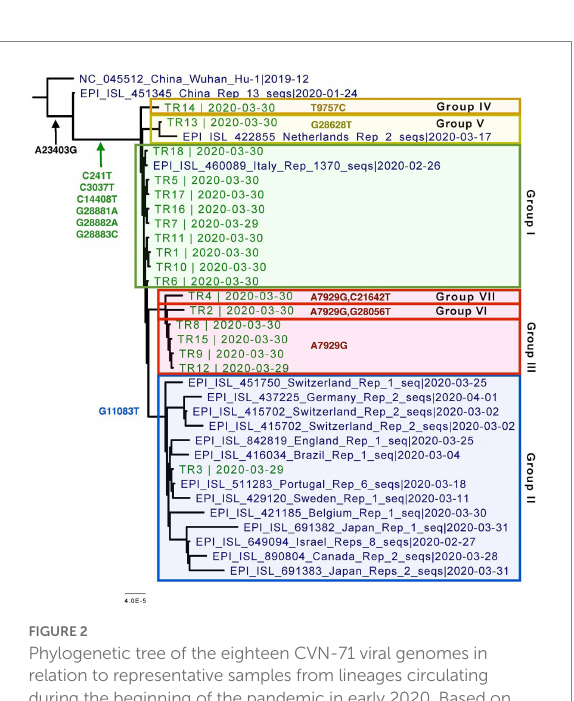
FIGURE 2 Phylogenetic tree of the eighteen CVN-71 viral genomes in relation to representative samples from lineages circulating during the beginning of the pandemic in early 2020. Based on the SNVs, groupings are shown in different colored boxes. Except for the two earliest references from China, which are B and B.1, the rest of the sequences included in the tree are B.1.1